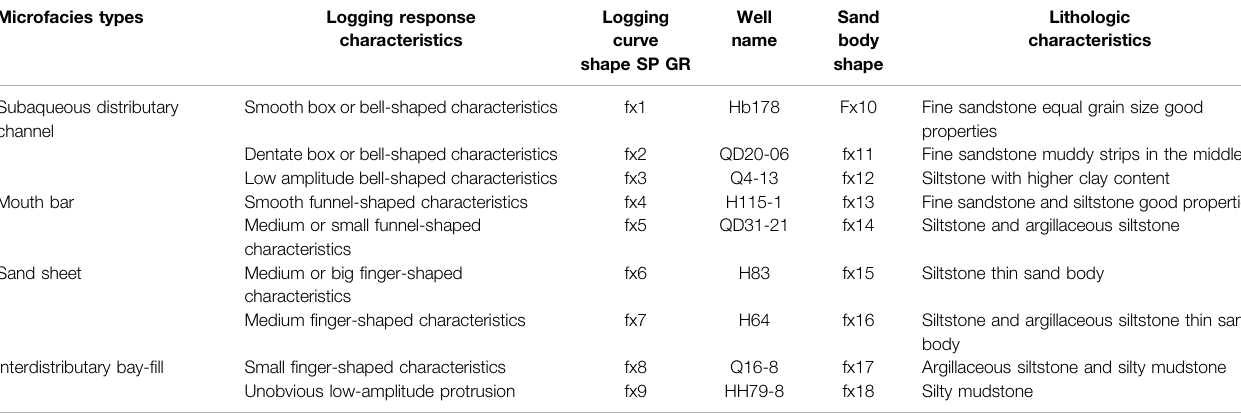
TABLE 1 | Corresponding relationship between sedimentary microfacies and logging